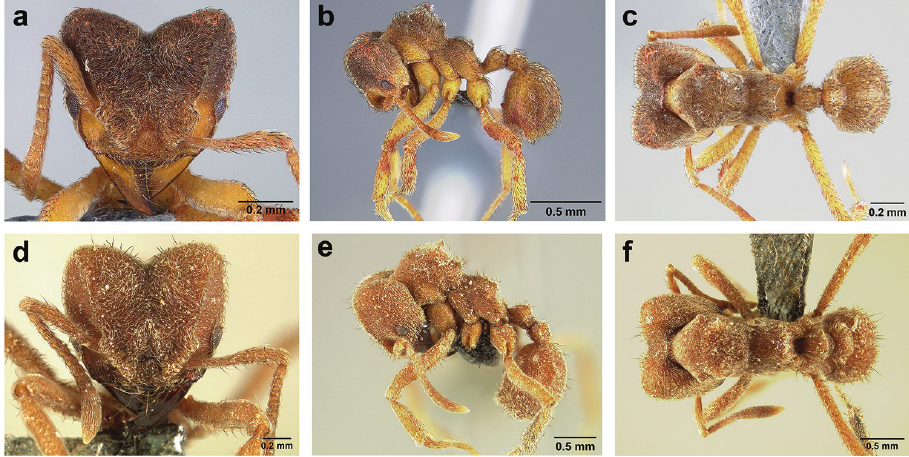
Figure 23. S. bondari worker variation. Worker with bicolored integument (USNMENT01125207) ( a, b, c ). Worker with reduced hairs (USNMENT01125823) ( d, e, f